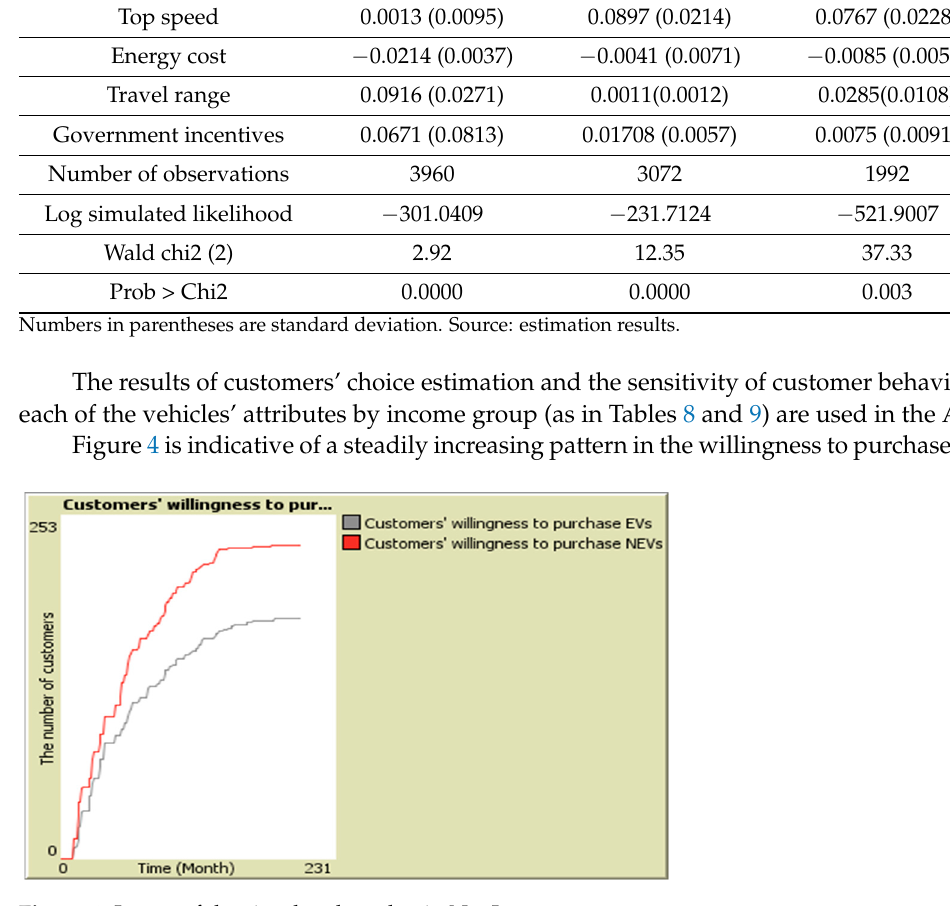
Figure 4. Image of the simulated market in Net